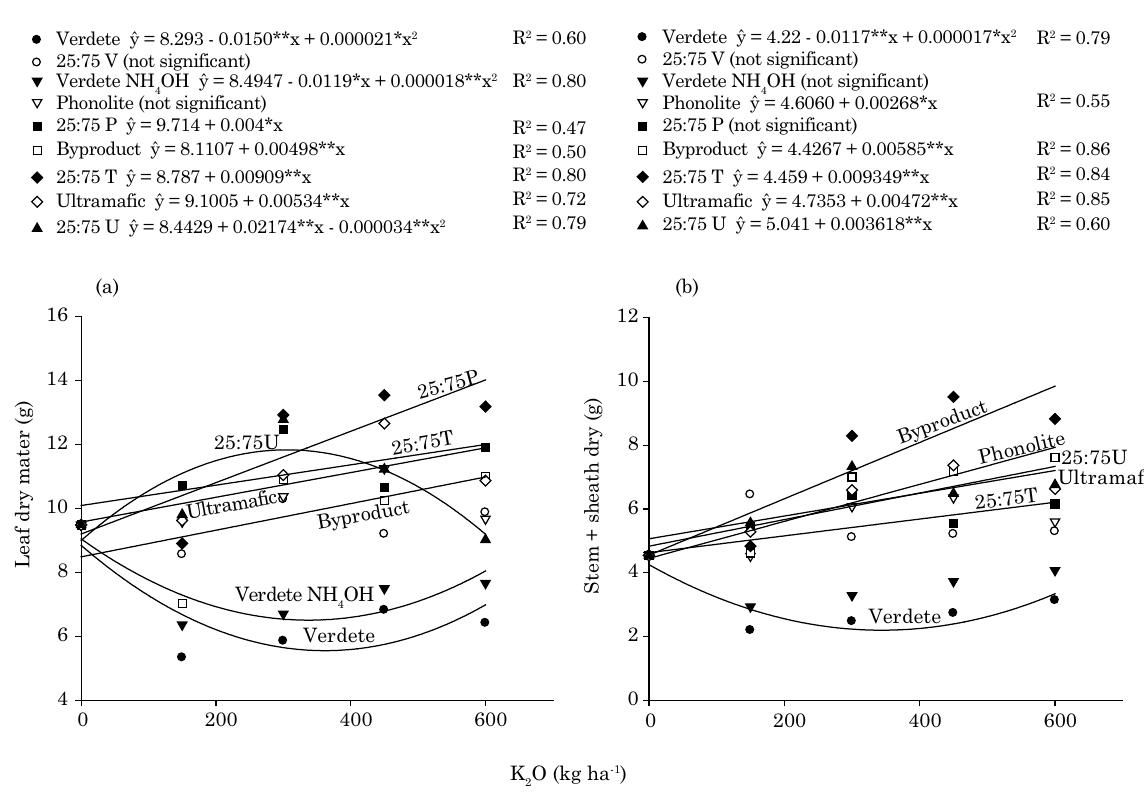
Means followed by the same uppercase letter in columns and lowercase letter in rows do not differ from each other at 5 % of significance by the Scott-Knott